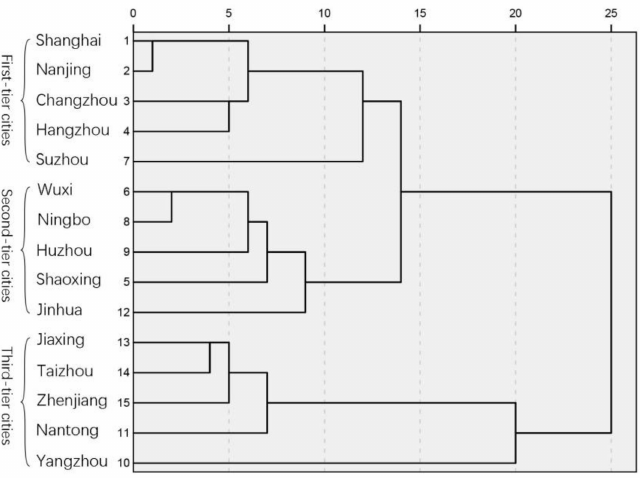
Figure 8. Cluster analysis of the overall CityIQ scores of these fifteen